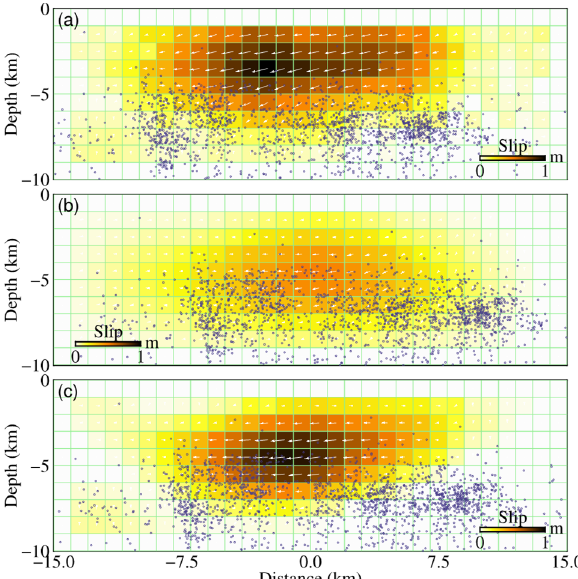
Figure 5. Coseismic source models. Dark slate blue circles are the aftershocks within seven days after the mainshock. White arrows represent the slip directions. ( a ) Model-A inverted only by ASC deformation, ( b ) Model-D only by DSC deformation, and ( c ) Model-J, which is the preferred source slip model, jointly inverted by ASC and DSC deformation.